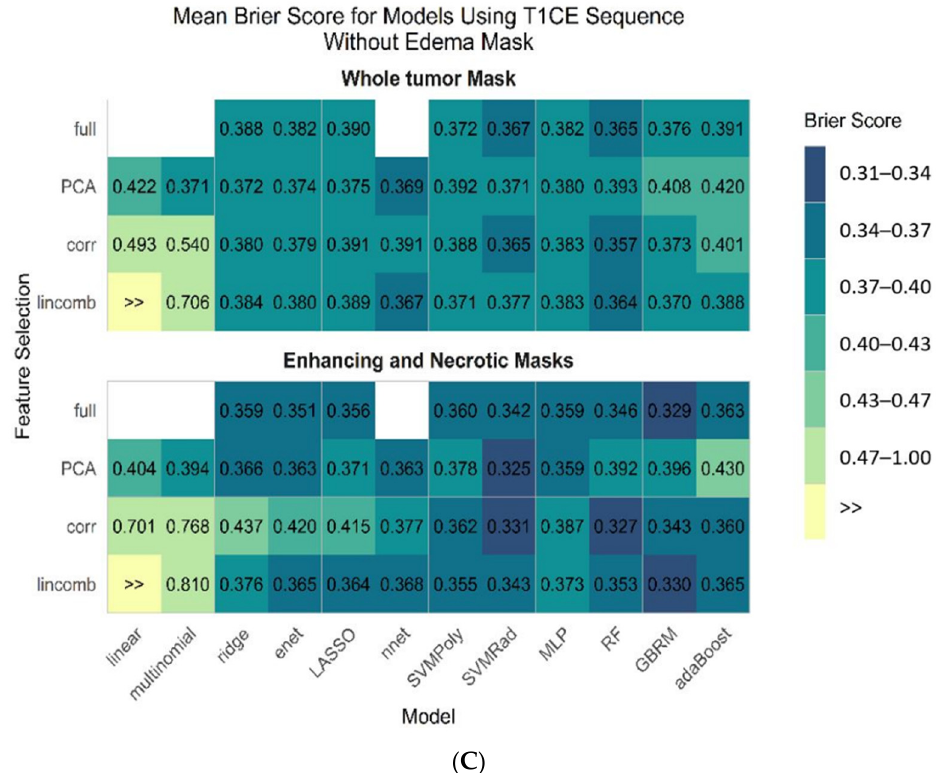
Figure 4. Mean estimate of cross-validated Brier score for all 45 model and feature selection combinations on both pipelines from all sequences ( A ), T1-CE sequence ( B ), and using T1-CE sequence without edema mask ( C ).